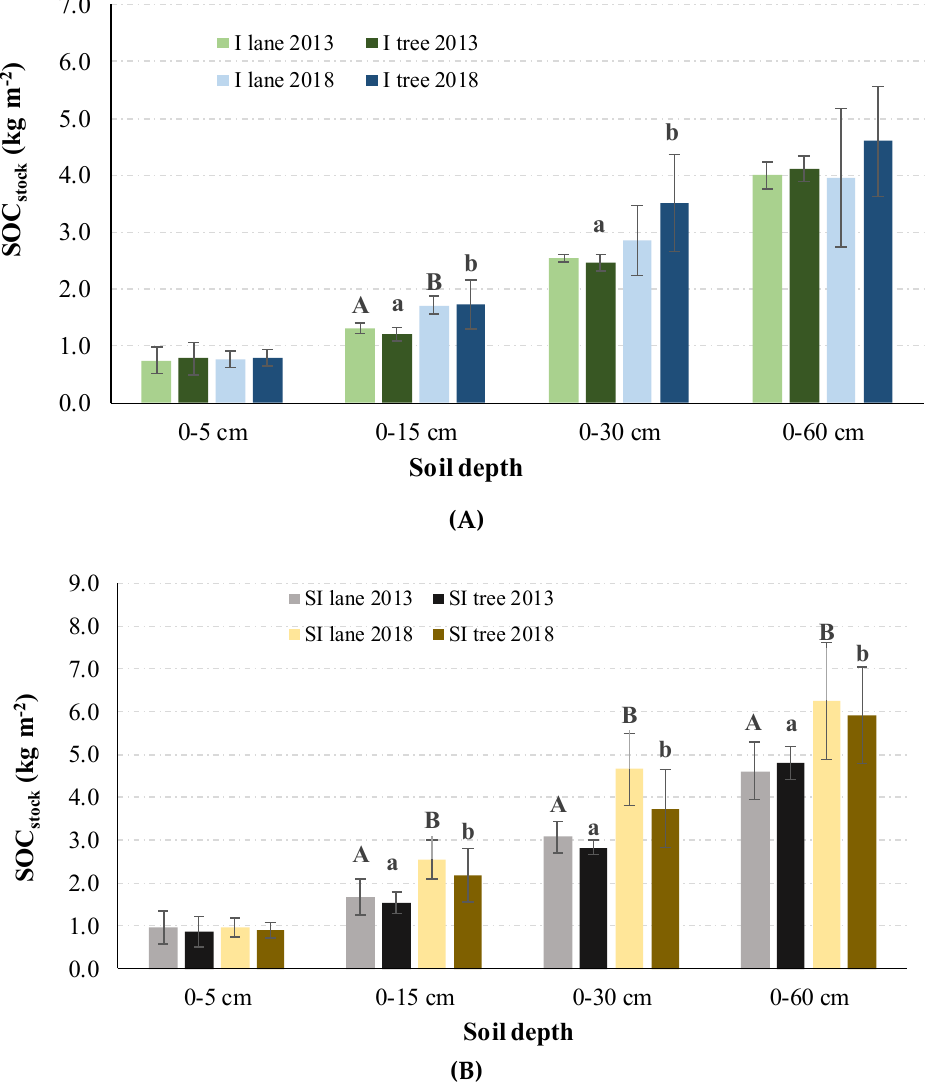
Figure 6. Comparison of cumulative soil organic carbon stock (SOC stock ; kg OC m − 2 ) evolution between 2013 and 2018 in the intensive ( A ) and superintensive ( B ) olive orchard. Different letters indicate statistically significant differences ( p < 0.05, using a Kruskal–Wallis test) between the two soil sampling dates for the same soil depth (0–5, 0–15, 0–30 and 0–60 cm) and location (lane, capital letters, or tree, lowercase letters) within each orchard. Error bars are standard deviation, n = 8.